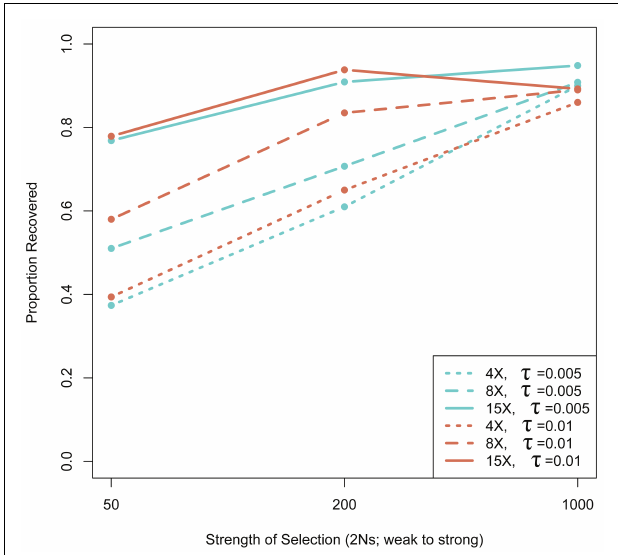
FIGURE 3 |The effect of next-generation sequencing on the power to infer selective sweeps. The proportion of simulated samples that rejected the null hypothesis with complete, pre-sequencing data and also rejected after sequencing is plotted as a function of the strength of selection.Thirty kilobase regions of 30 chromosomes with one selective sweep ( n = 100 for each α − τ ) were simulated. Simulations were compared to a null distribution generated by neutral simulations and considered significant at 0.05 cutoff.